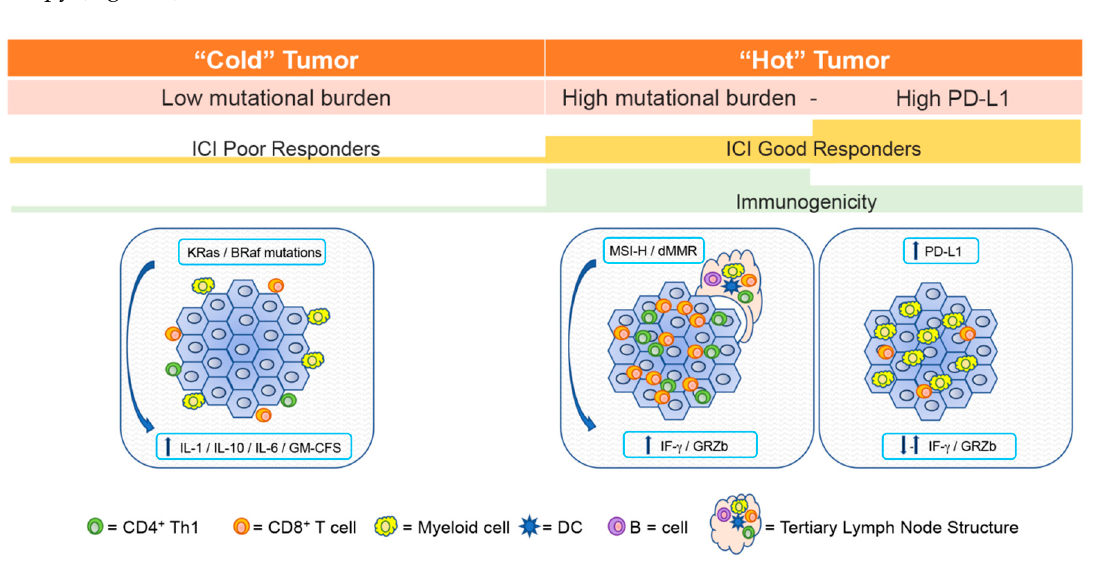
Figure 1. and “Hot” Tumors. Tumor microenvironments can be classified as immunologically “hot” (high immunogenicity) or “cold” (low immunogenicity), depending on tumor antigenicity, mutational burden, PD-1 and PD-L1 expression and lymphocyte infiltration. Histological evaluation of these parameters allows prediction of ICI responses. “Cold” tumors (I-E: Infiltrated Excluded) are characterized by poor CTL infiltration and by the presence along the tumor margins of tumor-associated macrophages (TAMs), likely preventing CTL infiltration into the core; these tumors are characterized by a frequent hyper-activation of the MAPK (Mitogen-Activated Protein Kinase) pathway, often maintained by Kras and Braf mutations, that sustains transcription of immunosuppressive lymphokines. “Hot” tumors (I-I: Infiltrated-Inflamed) are either characterized by PD-1 ligand (PD-L1) expression and high infiltration of PD-1 expressing CTLs, or by high mutational burden sustaining neo-antigens production and high infiltration of leukocytes, sometime organized in tertiary lymph node